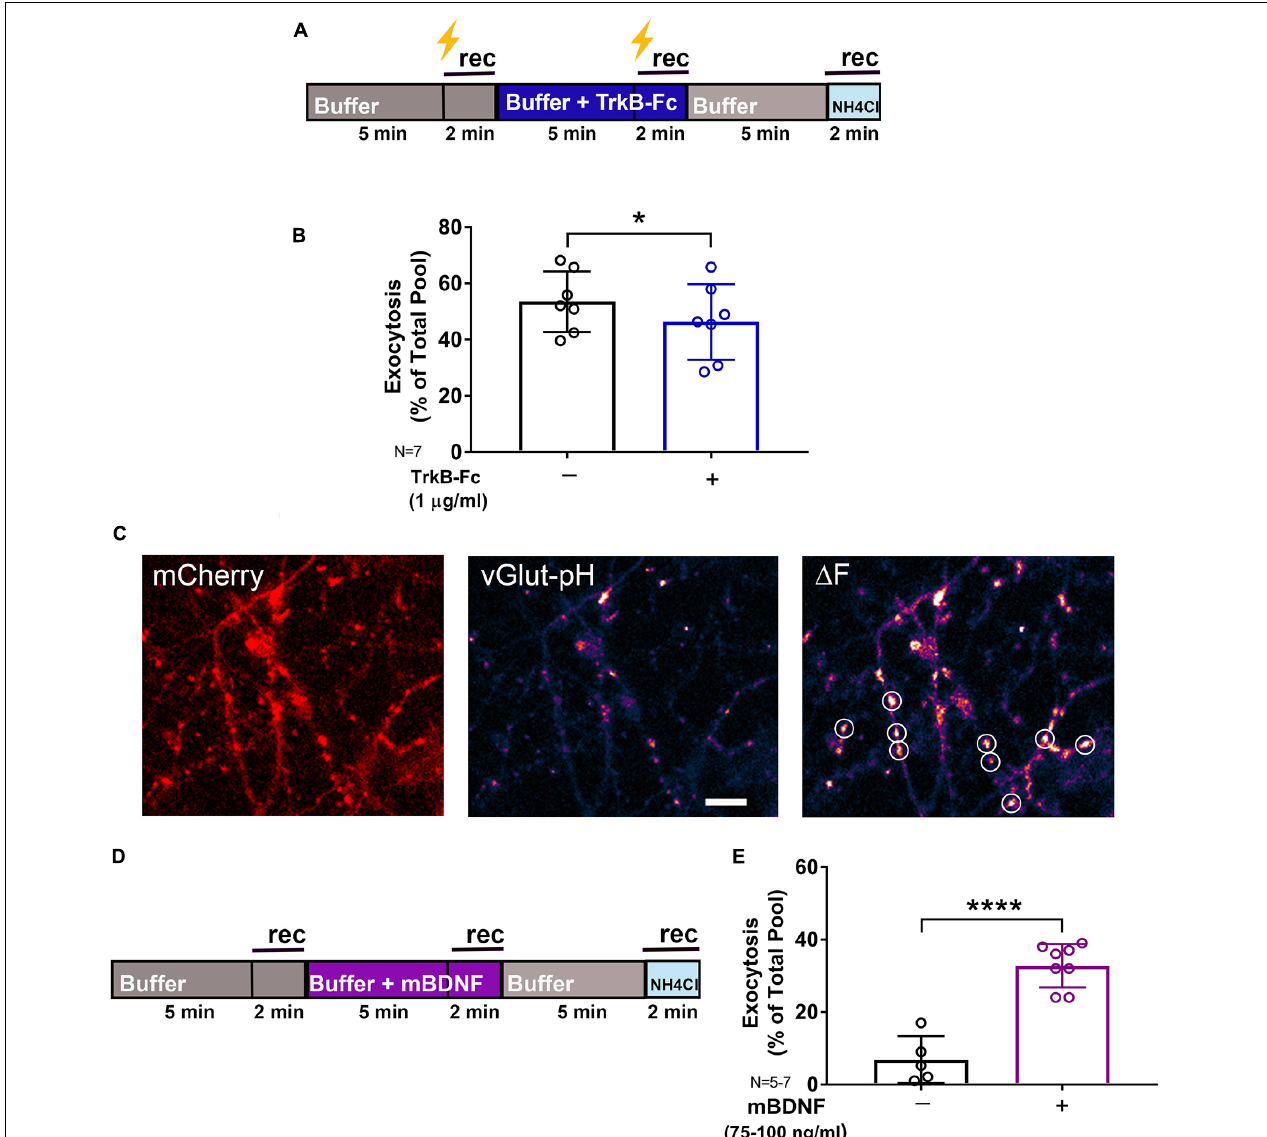
FIGURE 2 | Endogenous BDNF contributes to synaptic vesicle exocytosis. Rat hippocampal neuron cultures (16DIV) transfected with vGlut-pH and mCherry were perfused with TrkB-Fc (1 µ g/ml) prior to tetanic stimulation (lightning bolt; A ) or mBDNF with no stimulation (D) and imaged as indicated. Quantification of electrically-evoked synaptic vesicle exocytosis shows that pretreatment with the BDNF binding protein TrkB-Fc (1 µ g/ml) for 5 min prior to tetanic stimulation reduced exocytosis (B) (* p < 0.05 by Student’s paired t -test). Representative images of rat hippocampal neurons (16DIV) transfected with mCherry ( C , left) and vGlut-pH showing single boutons before ( C , middle) and after ( C , right) addition of exogenous mBDNF (75–100 ng/ml) with defined ROIs used for analysis (white circles). Synaptic vesicle exocytosis was increased by mBDNF without stimulation (E) (**** p < 0.0001 by Student’s paired t -test). Data are mean ± SD; n = 5–7 neurons per experimental group and 250–350 boutons. Scale bar = 5 µ